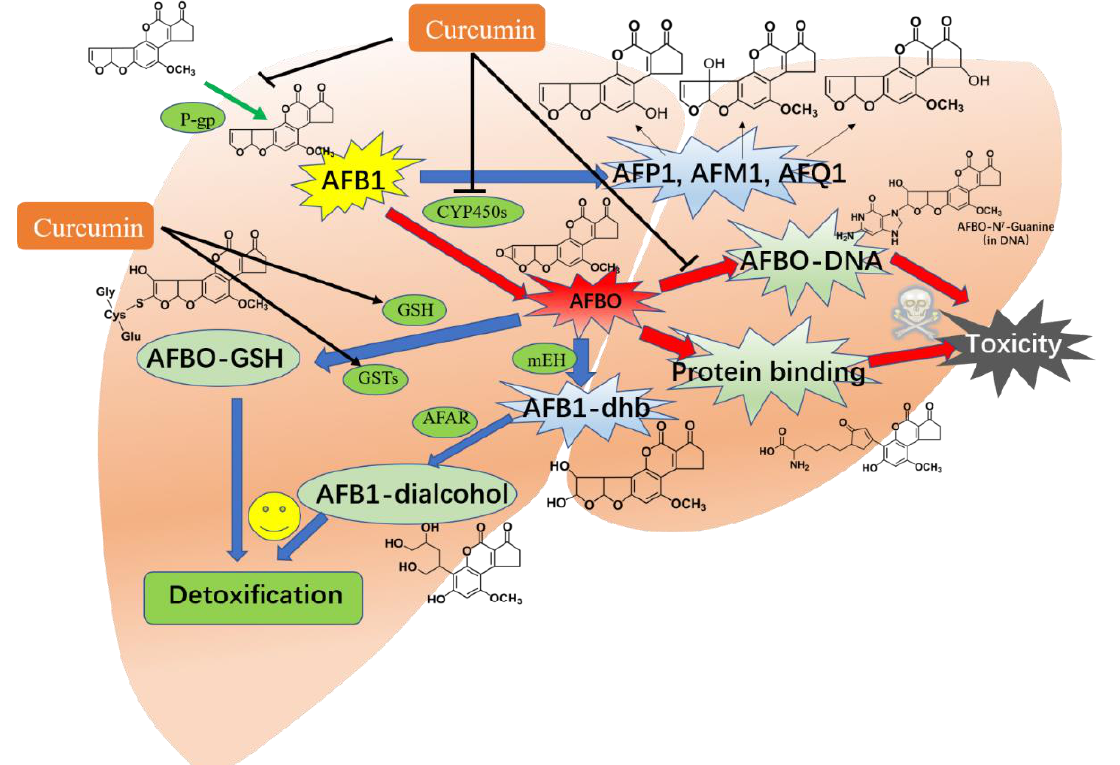
Figure 6. Overview of the metabolism pathways of AFB1 and the modulation of curcumin. Curcumin could regulate the AFB1 uptake and intracellular metabolism by regulating the expression of P-gp and GSTs proteins and the activities of CYP450s and the formation of AFBO-DNA adduct. AFB1, aflatoxin B1; aflatoxicol M1; aflatoxin P1; AFQ1, aflatoxin Q1; AFB1-dhd, AFB1-8,9-dihydrodiol; AFAR, aflatoxin-aldehyde reductase; AFBO, exo-AFB1-8,9-epoxide; GSTs, glutathione S-transferases; GSH, glutathione; mEH, microsomal epoxide hydrolase; CYP450s, cytochrome P450s; P-gp, P-glycoprotein. This figure is modified based on the original figure published in Deng et al. [167].